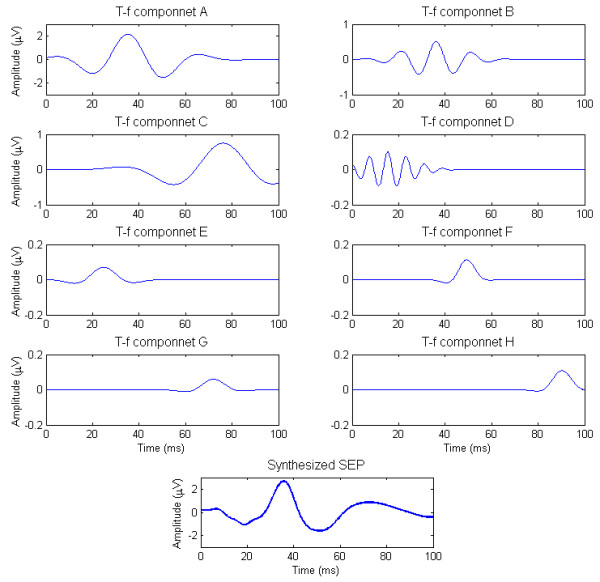
A synthesized rat SEP signal and its t-f components. Waveforms of eight classes of stable t-f components were synthesized using the mean values of parameters for t-f components in Table R1. The typical SEP waveform was obtained as the sum of eight synthesized t-f components. These waveforms are plotted in different scales.